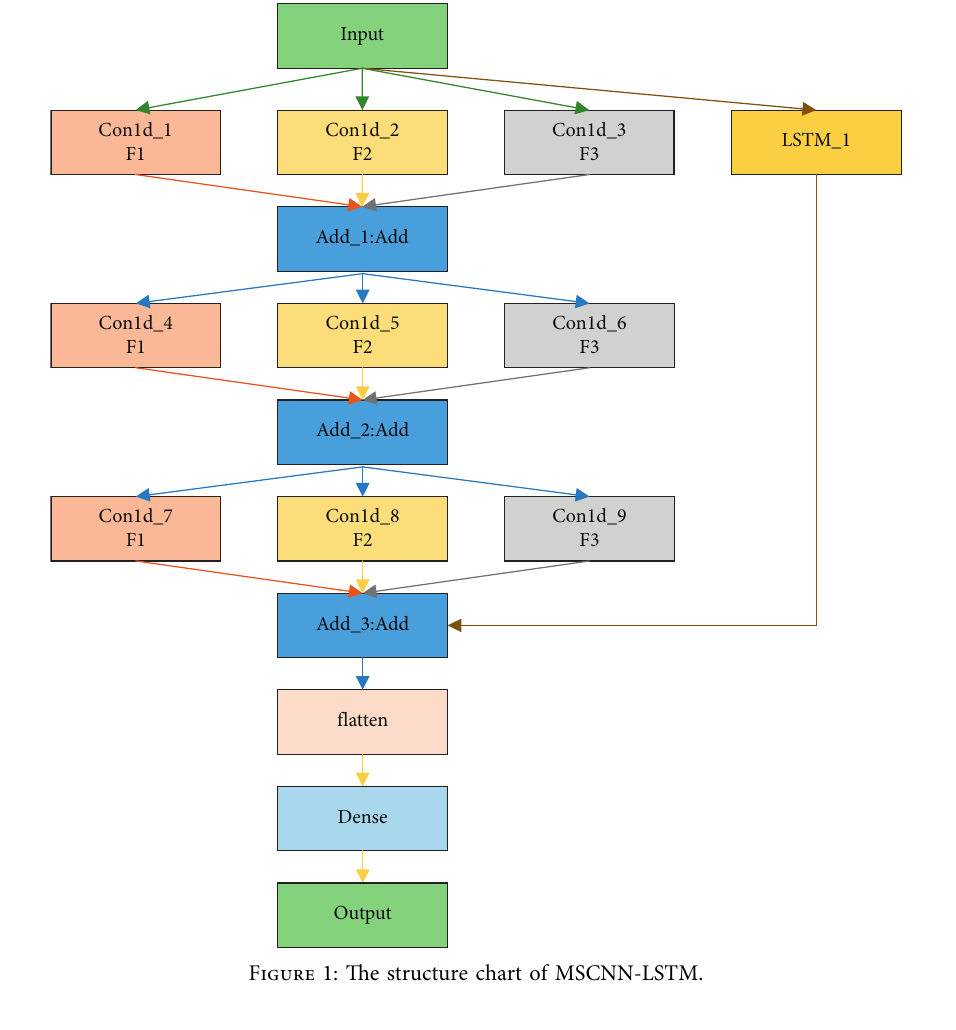
Figure 1: The structure chart of MSCNN-LSTM.